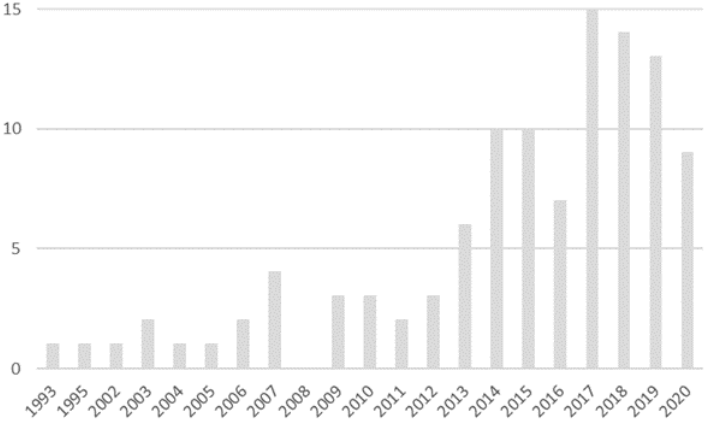
Figure 3. Number of articles per year .